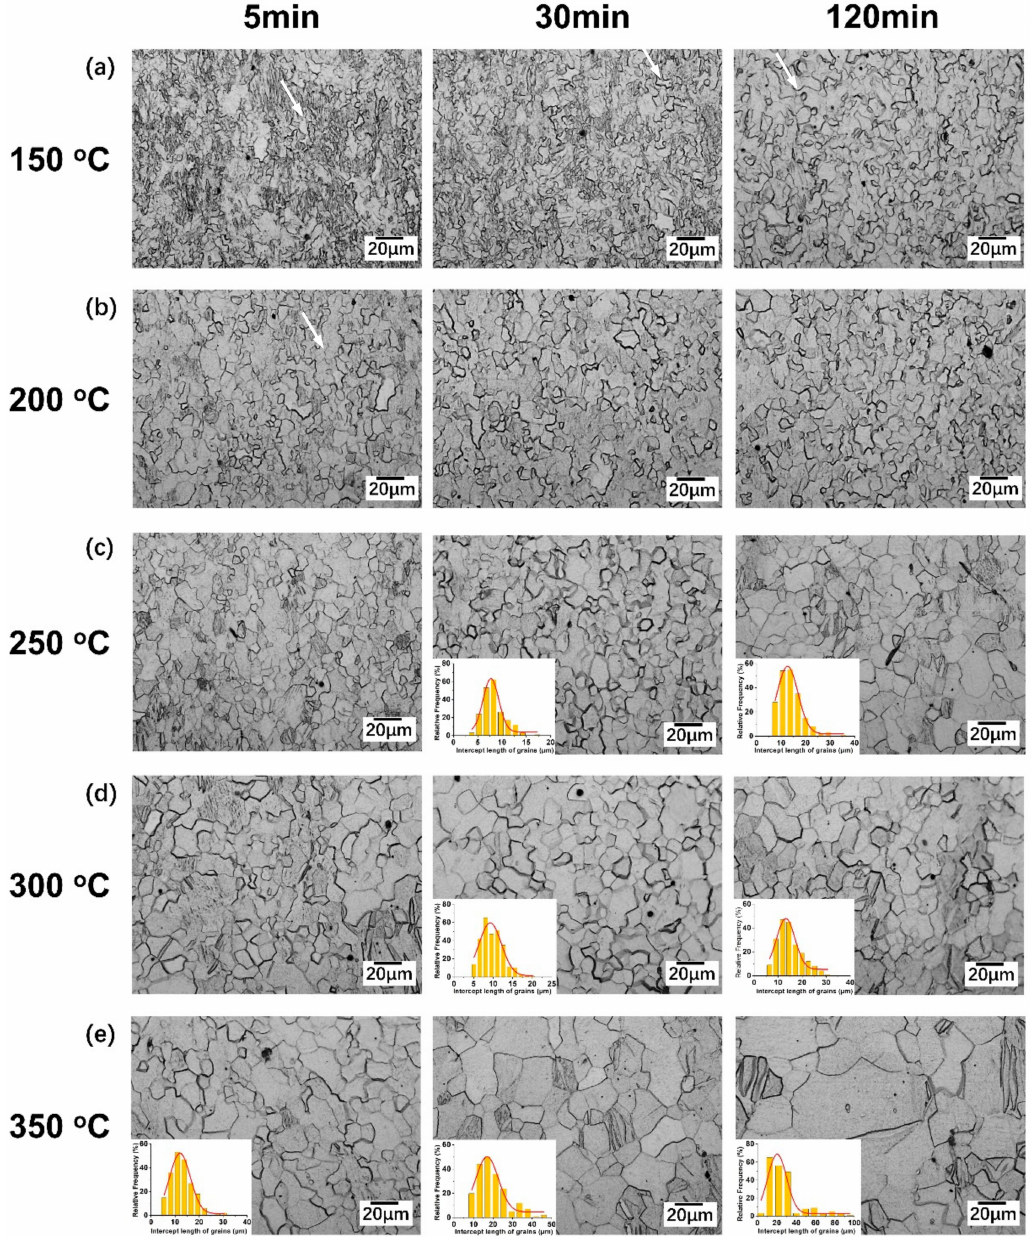
Figure 2. Annealed microstructures of pure Mg with di ff erent annealing temperatures after 5, 30 and 120 min. ( a ) 150 ◦ C; ( b ) 200 ◦ C; ( c ) 250 ◦ C; ( d ) 300 ◦ C; ( e ) 350 ◦ C. The grain intercepts (size) distribution histograms of these completely recrystallized samples are shown at the bottom